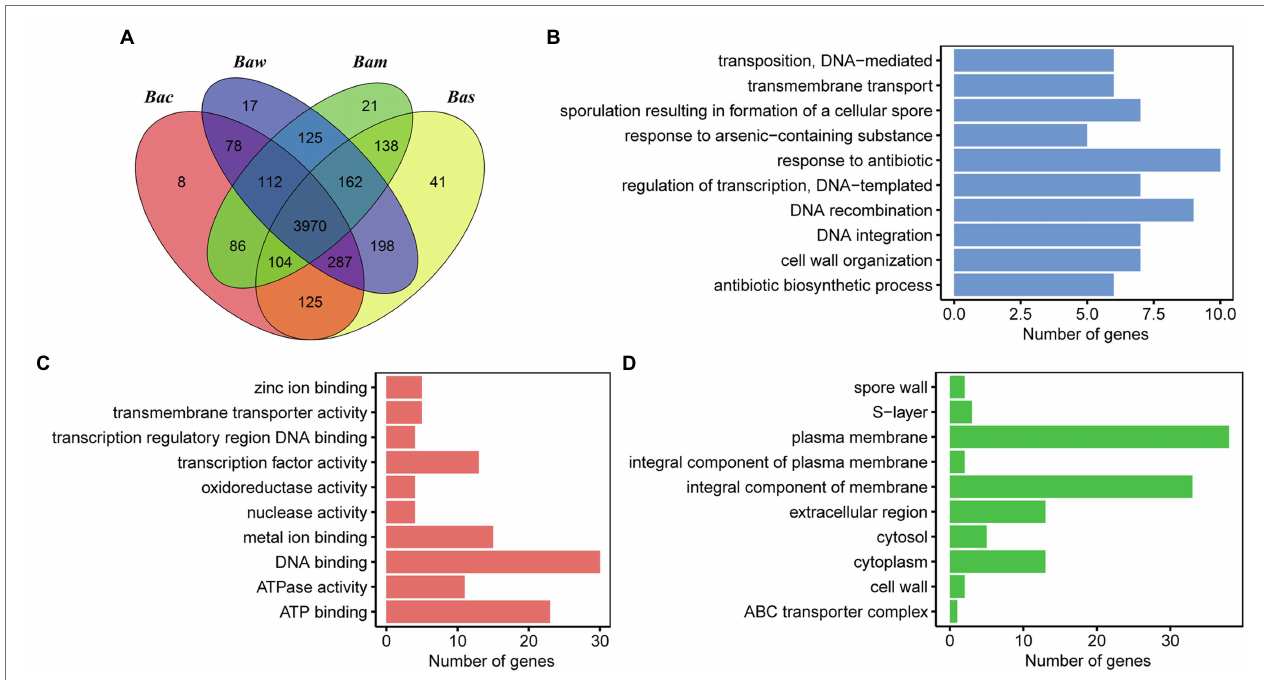
FIGURE 7 | Comparison of orthologous genes in genomes of strains PGP15, B. cereus BC33, B. wiedmannii SR52, and B. mycoides BPN36/3. (A) Venn diagram representing the numbers of shared and unique ortholog groups among the four genomes. The ortholog groups identified by OrthoMCL software are shown. Bac, B. cereus BC33; Bam, B. mycoides BPN36/3; Bas, Bacillus sp. PGP15; Baw, B. wiedmannii SR52. (B–D) GO annotation of unique genes (i.e., genes are not included in any ortholog groups) in the PGP15 genome. The three main GO categories, including biological process (B) , molecular function (C) , and cellular component (D) , are